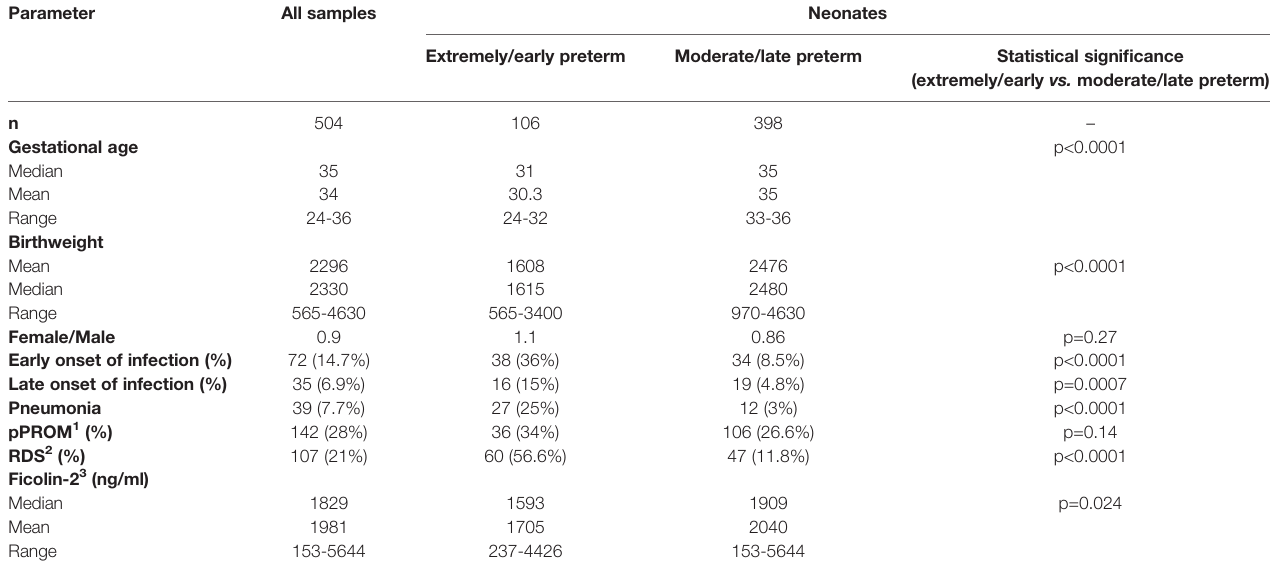
TABLE 1 | Basic clinical characteristics of the study group. Parameter All